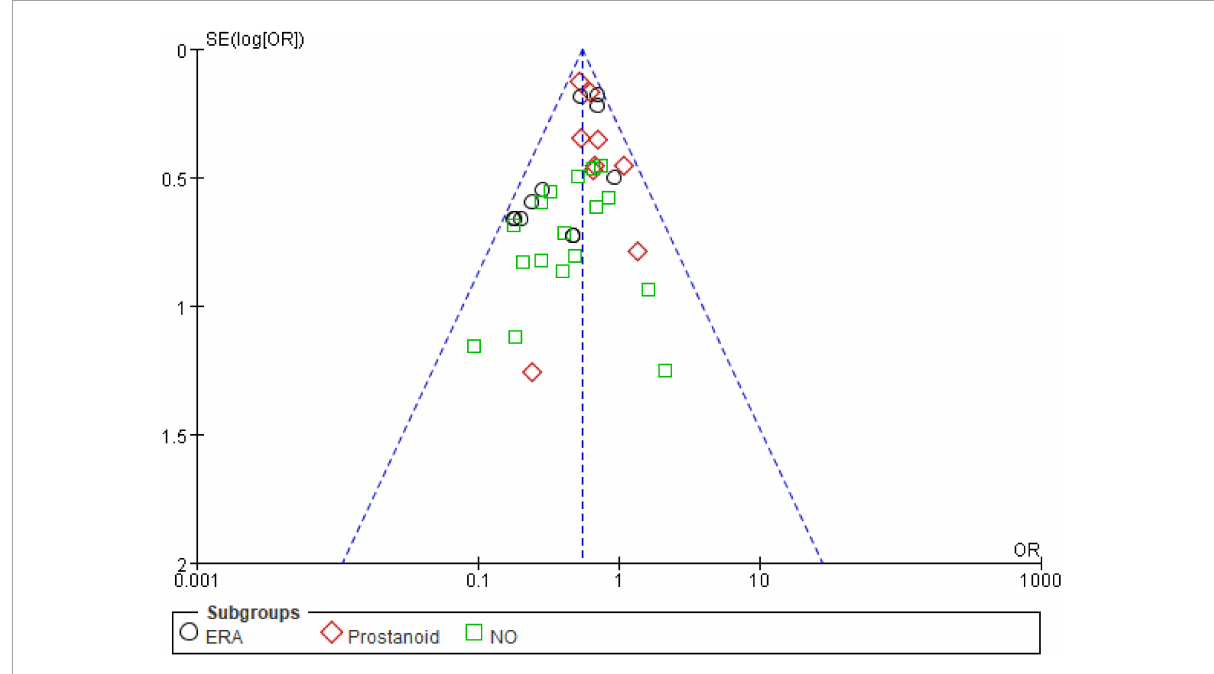
FIGURE5 Funnel plot for the effect of oral targeted drugs on worsening events.